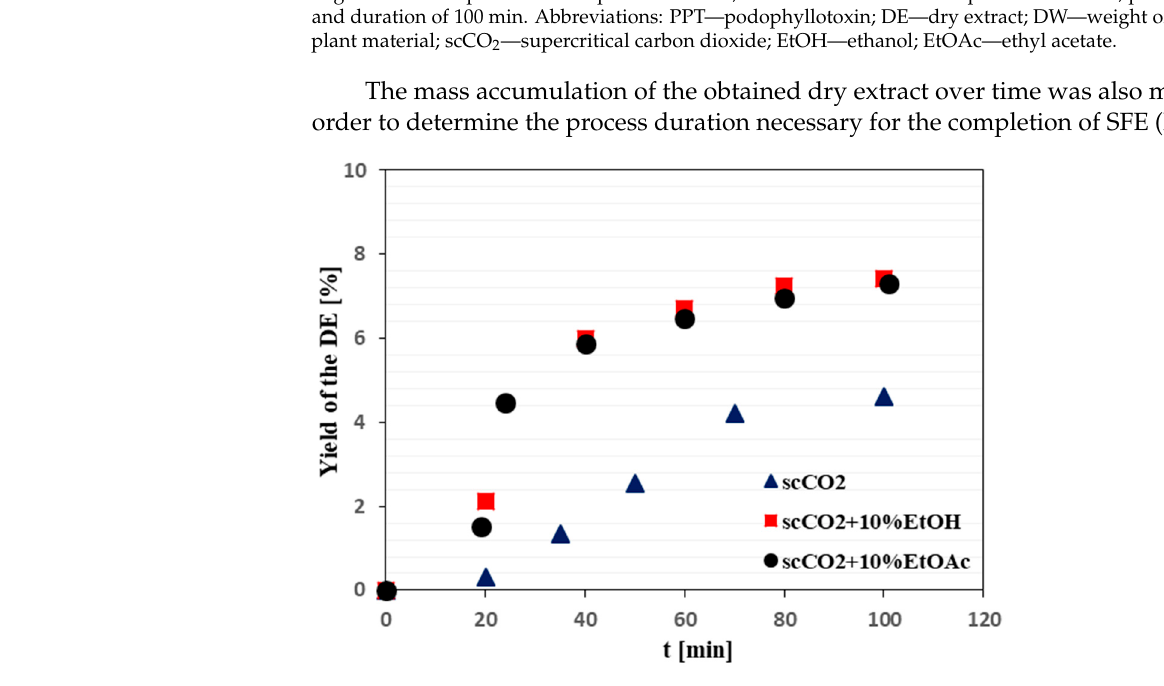
Figure 6. Effect of the SFE duration on the yield of dry J. virginiana leaf extract. Abbreviations: